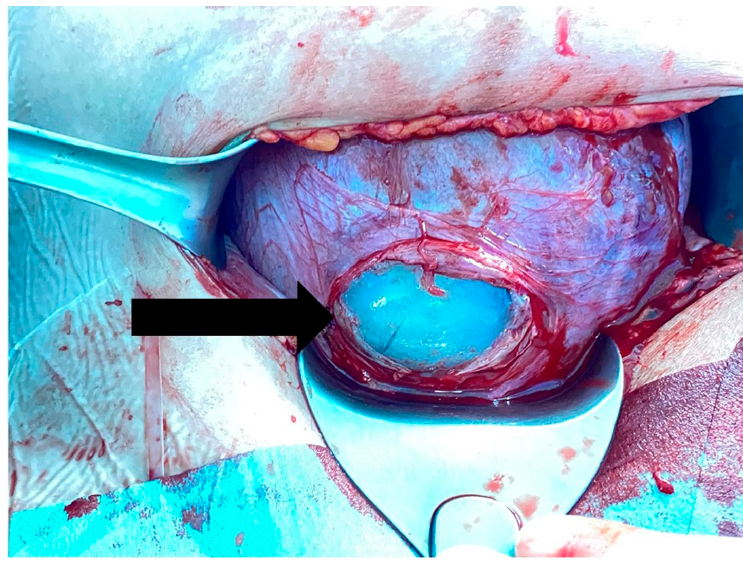
Figure 1. Amniotic membrane (arrow) is exposed after the myometrium is incised with shallow strokes during cesarean section. strokes during cesarean